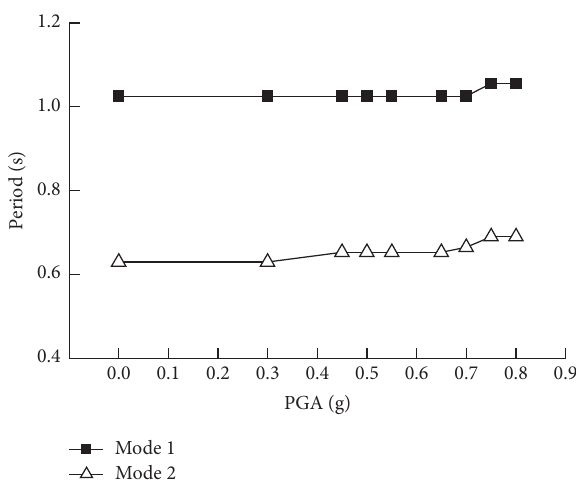
Figure 9: Period shifts of first and second longitudinal modes.